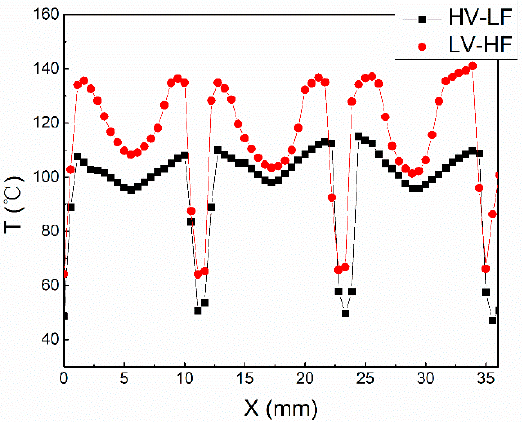
Figure 9. The surface temperature distribution 10 s after NS-DBD plasma actuator was switched on at room temperature (25 °C) and normal atmospheric pressure: ( a ) LV-HF discharge; ( b ) HV-LF discharge.